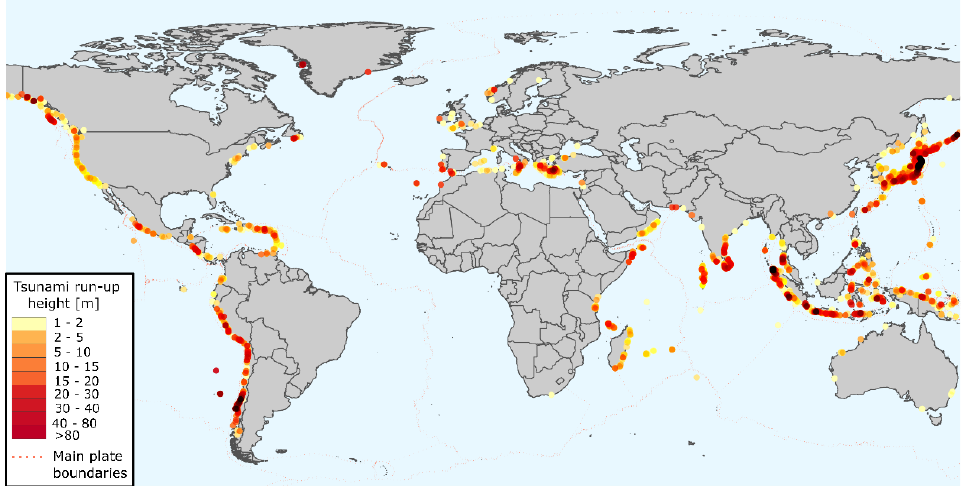
Figure 2. Worldwide spatial distribution of tsunami run-up heights. Darker (red) dots indicate recorded run-up heights in excess of 20 m